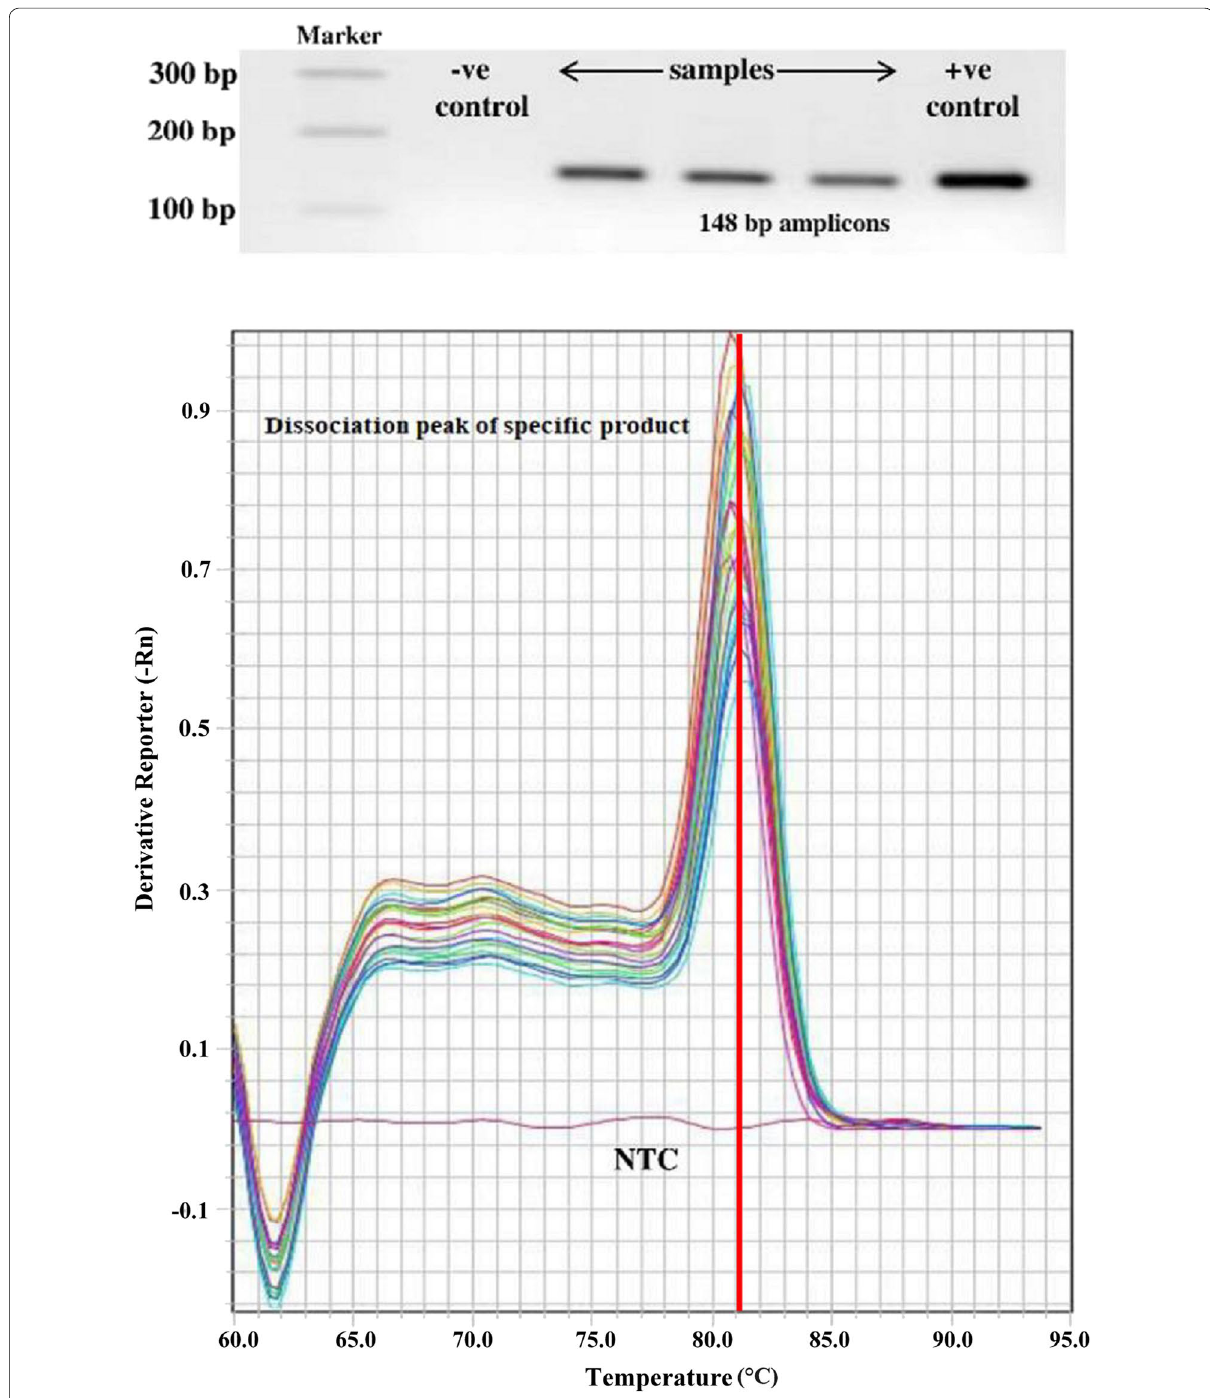
Fig. 2 Specific dissociation peak of WSSV positive samples by melt curve analysis with corresponding conventional PCR amplicon (148 bp) target‑ ing VP28 gene of WSSV. The ethidium bromide‑stained agarose gel (1.5%) was used to visualized 148 bp PCR amplicon generated by qVP28F and qVP28R primers. The Tm value (81.1 17 °C) of real‑time PCR specified the unified WSSV amplicon in the ±